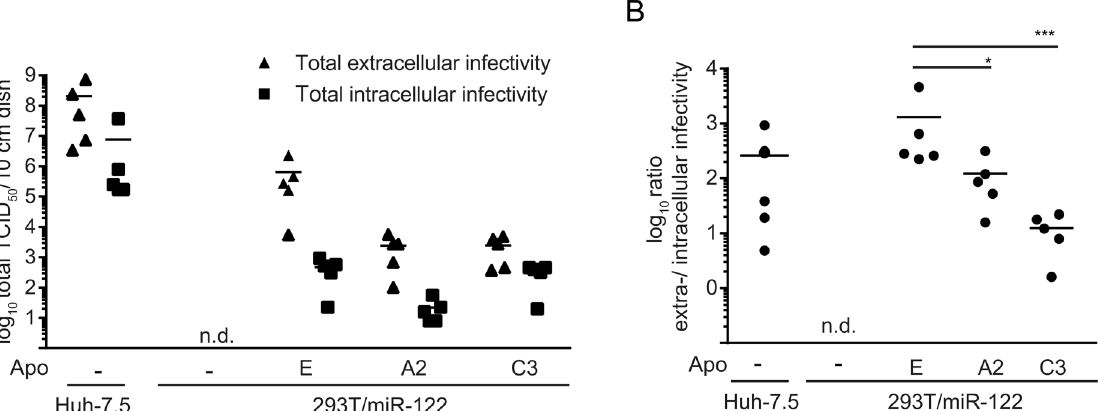
Fig 4. Different ratio between extracellular and intracellular infectious virus production in HCV transfected Huh-7.5 and 293T/miR-122 cells. A: Depicted cell lines were transfected with HCV RNA (Jc1) and after 48 h, production of infectious virus particles was assessed in the cell culture supernatants as well as in freeze-thaw lysates by limited dilution assay. Shown are the viral titers per 10 cm culture dish. B: Ratio of extra- to intracellular infectivity was calculated based on data presented in panel (A). Statistical analyses were performed by Dunnett ’ s multicomparison test. Significant changes in infectivity of cells expressing ApoA2 or ApoC3 compared to ApoE are indicated. ( * = p < 0.005, *** = p <